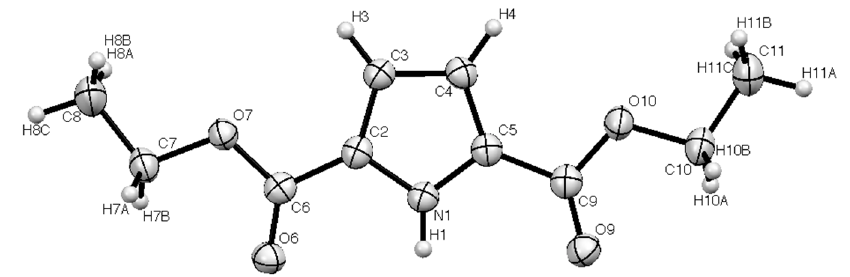
Figure 1. The molecular structure of 1 with numbering